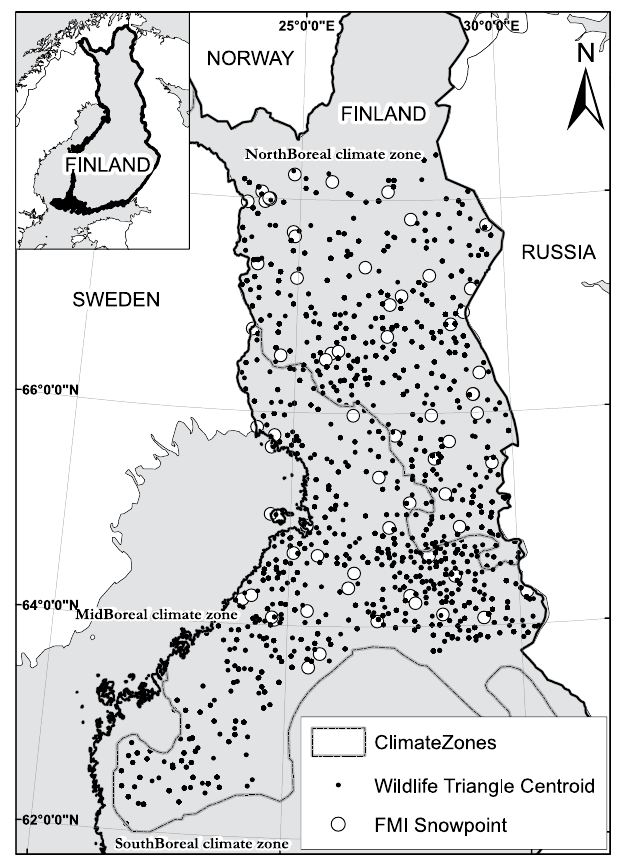
Figure 1. The study area and the distribution of wildlife triangles in Finland. The excluded area in northern Finland approximates the area where the forest willow grouse ceases to exist, and the populations are formed by the tundra willow